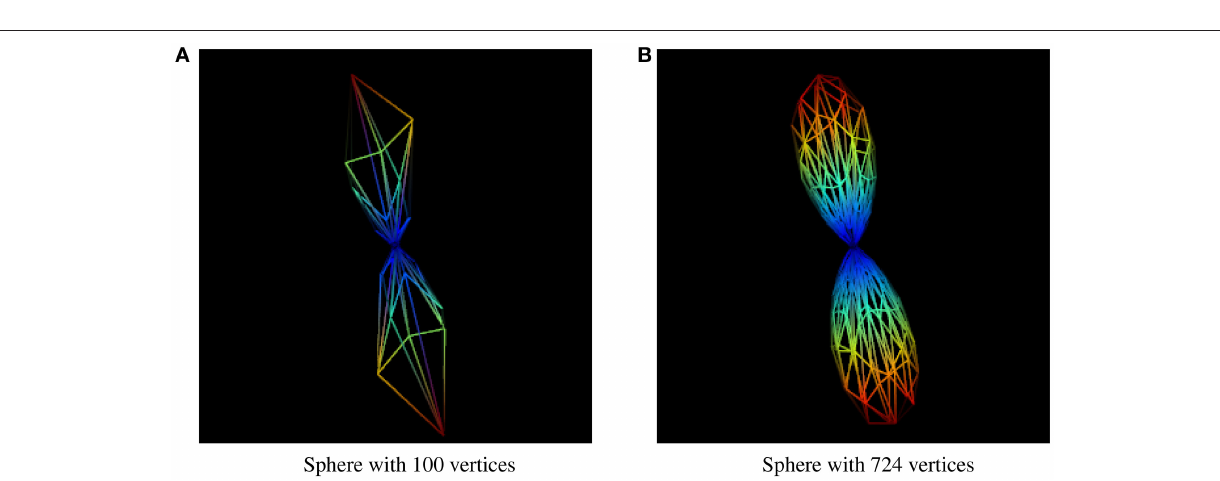
selection box, and through streamlines reconstruction in